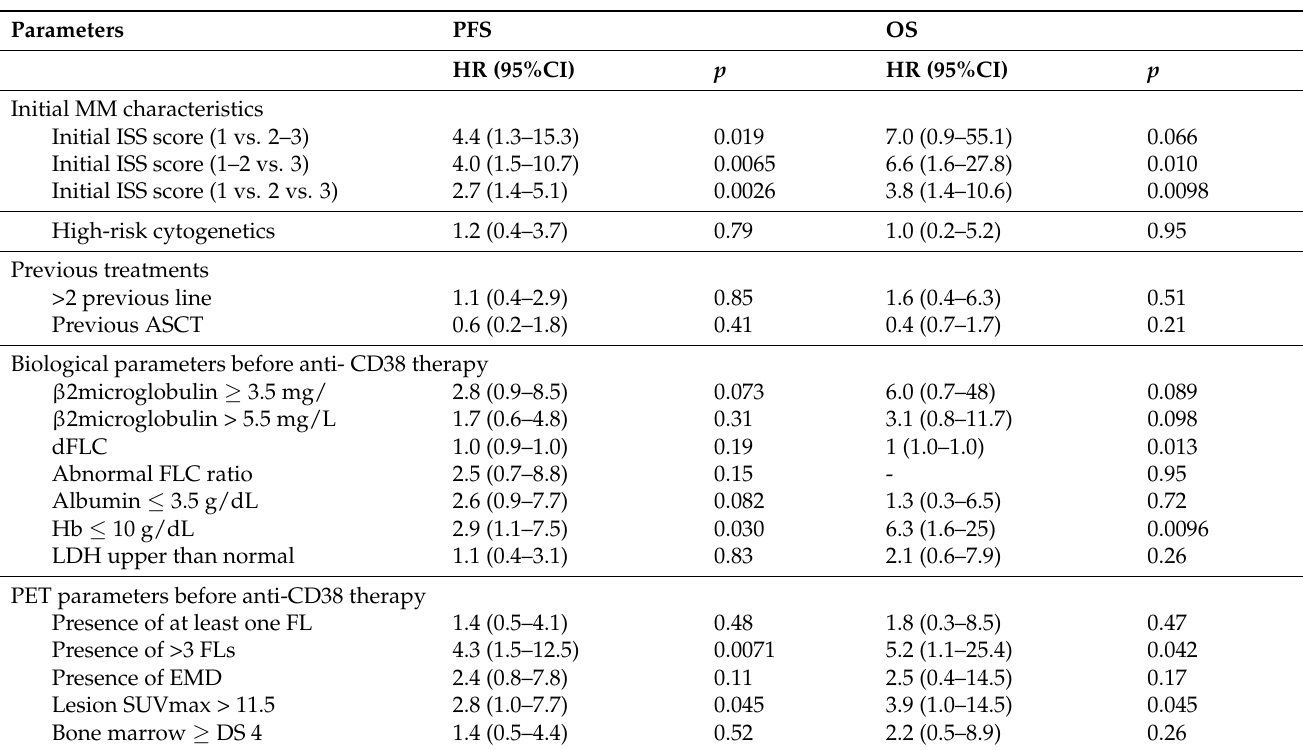
Table 3. Cox regression analyses of the clinical, biological, and FDG PET/CT parameters associated with overall and progression-free survival.